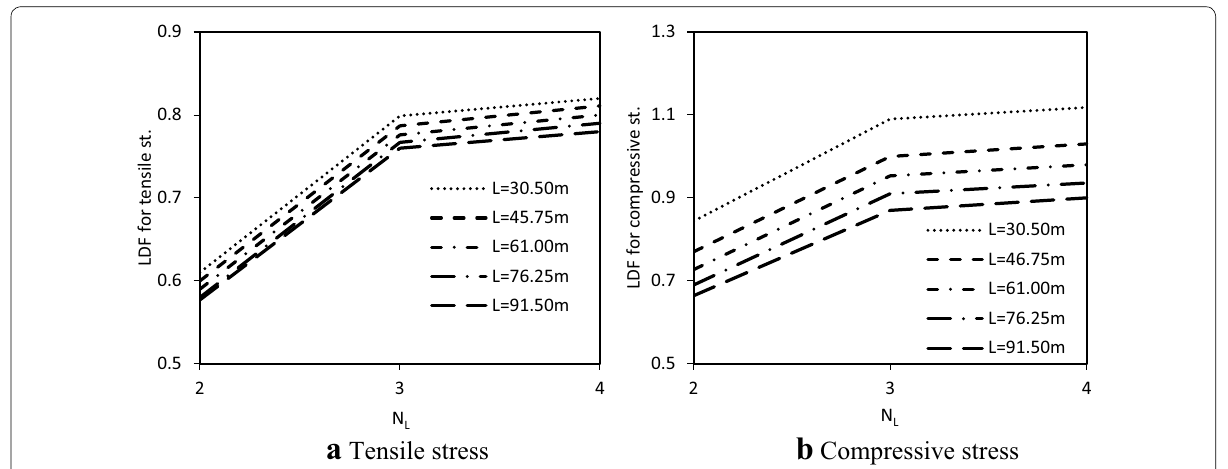
Fig. 12 Relationship between the stress distribution factor and the number of lanes of three box bridges with different lengths.